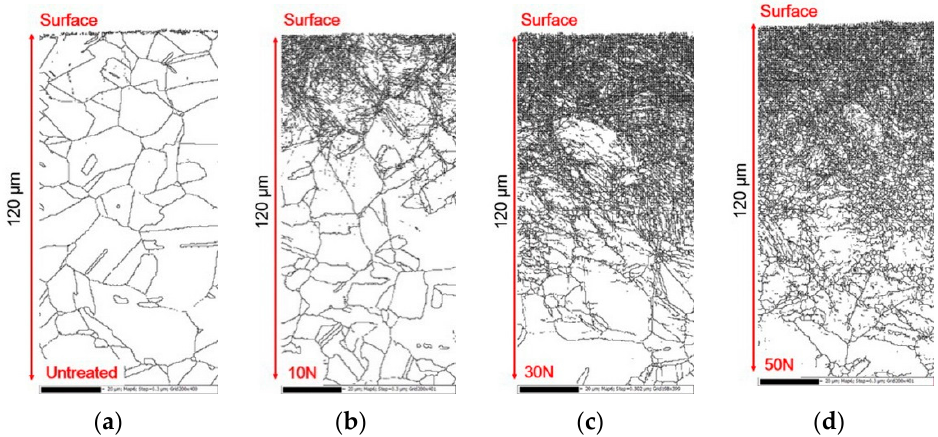
Figure 4. The effect of the static load in UNSM treatment on the grain refinement depth profile of Alloy 600 by EBSD (×600): ( a ) untreated; ( b ) 10 N; ( c ) 30 N; ( d ) 50 N.